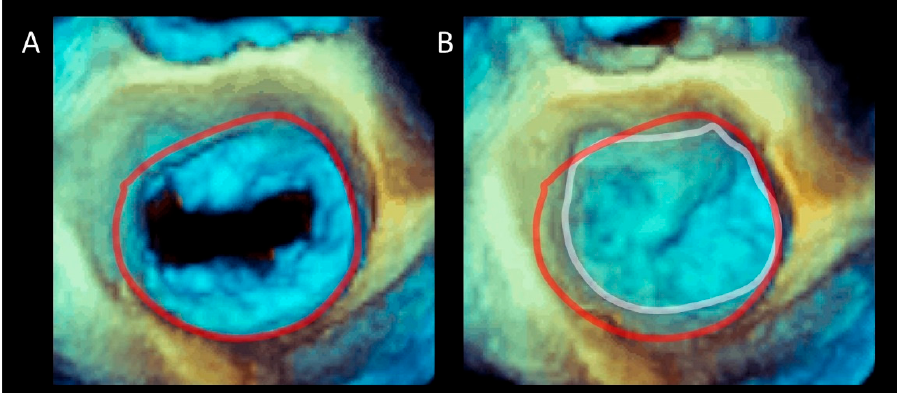
Figure 3. Three-dimensional TEE image of the mitral valve (MV) from an overhead perspective in ( A ) diastole and ( B ) systole. The sphincteric action of the annulus is marked with a red (diastolic) and white (systolic) circumference.